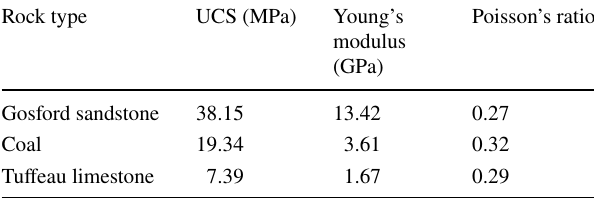
Table 1 Mechanical properties of the rock Rock type